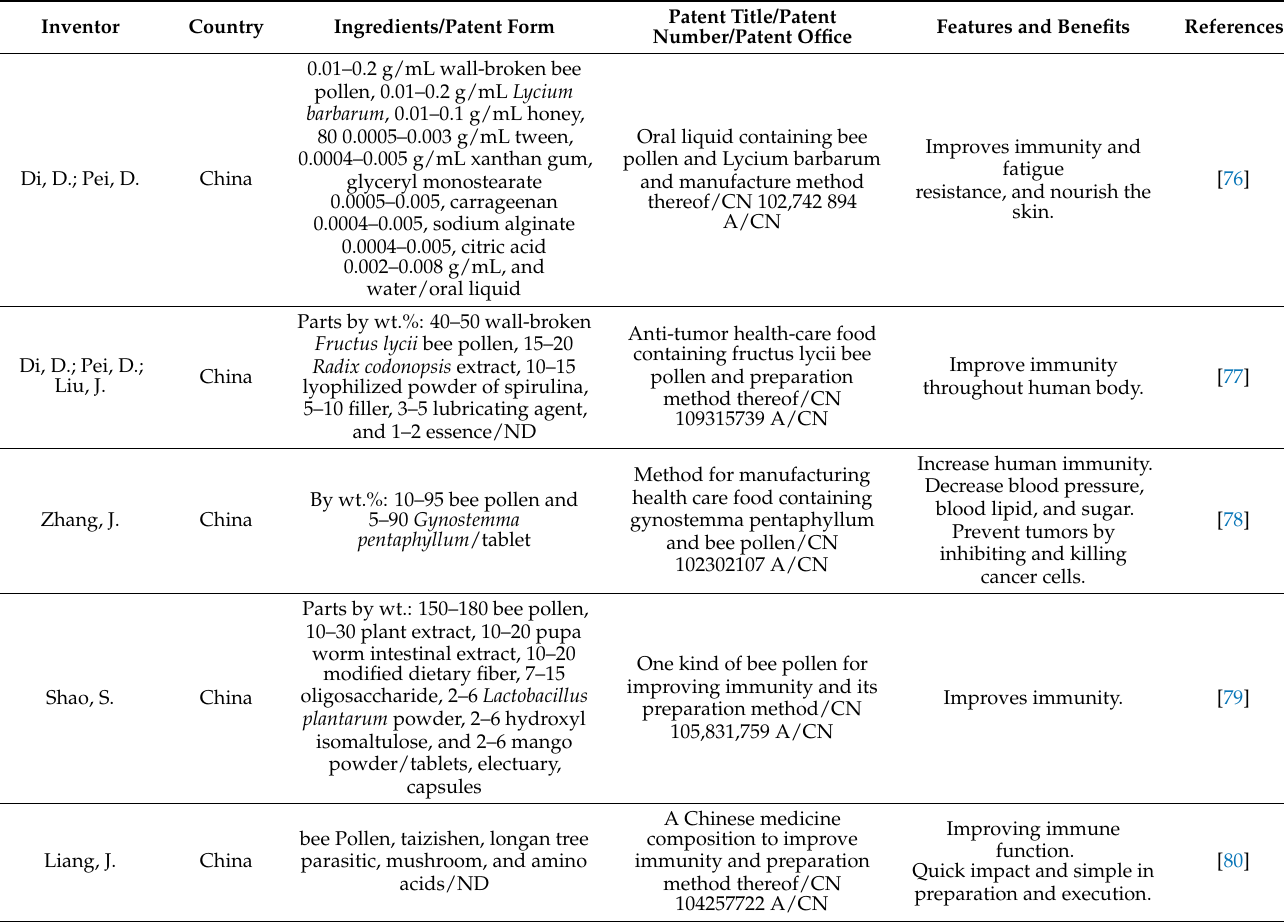
Table 3. Different forms of bee pollen for immunity-related